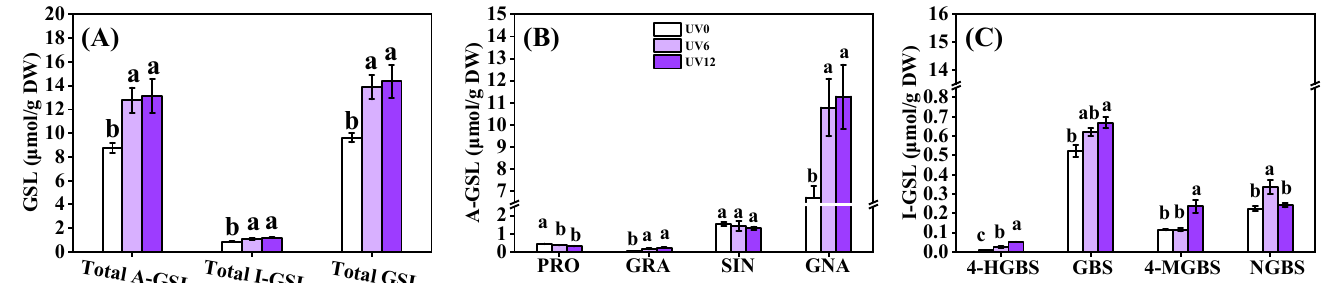
Figure 8. Glucosinolate profiles of Chinese kale subjected to different durations of UVA-radiation exposure. ( A ) GSL (glucosinolate). ( B ) A-GSL (aliphatic glucosinolate). ( C ) I-GSL (indolic glucosinolate). Different lowercase letters (a–c) labeled on the vertical bar (means ± standard error, n = 3) represent significant differences by one-way ANOVA with multiple-range tests ( p ≤ 0.05).